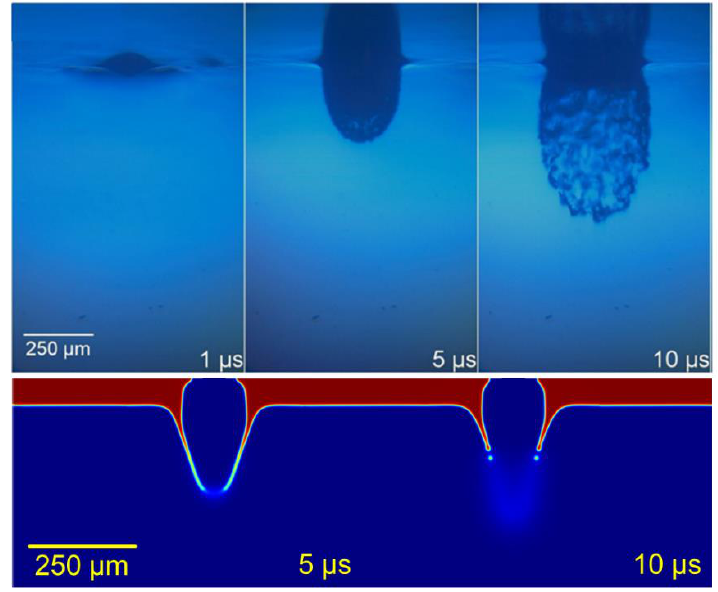
Figure 5. Explosive regime. Upper row adapted from [13], with PV17F paste. Lower row: simulation at 450 MPa at its maximum, for 60 μm of 2 Pa·s paste .